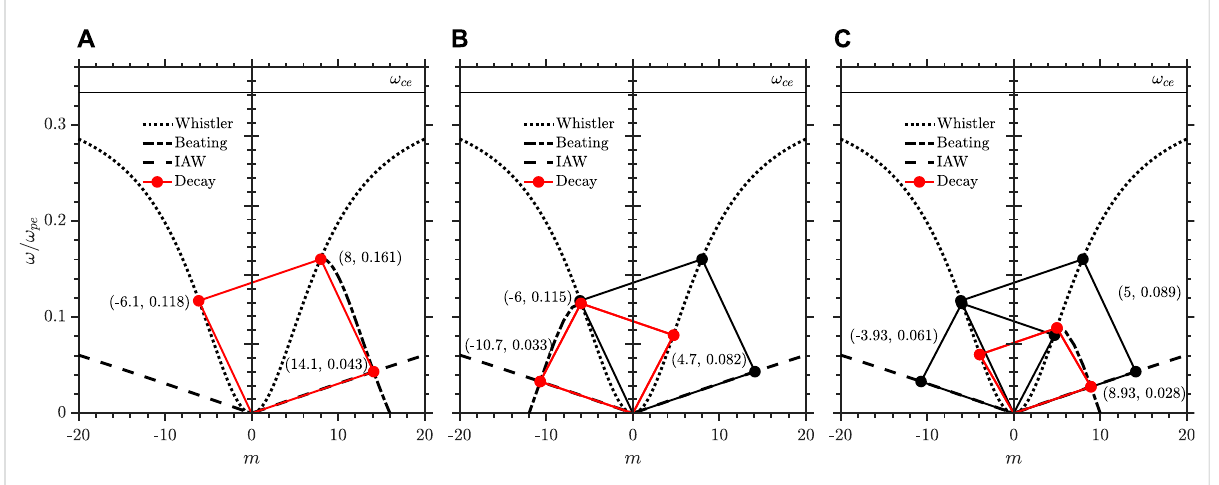
FIGURE 4 Cascading parametricdecay paths. Thedotted curveisthewhistler branch, thedash-dottedblackcurveistheponderomotive beatingwith the counter-propagating low-frequency whistlers, and the dashed black line is the ion acoustic wave. The parametric 3-wave coupling is indicated by the solid red curve where the ( x , y ) pairs in each panel are the locations of the red circles (A) Primary decay of pump whistler wave. (B) Secondary decay of the daughter whistler wave. (C) Tertiary decay of the secondary daughter whistler